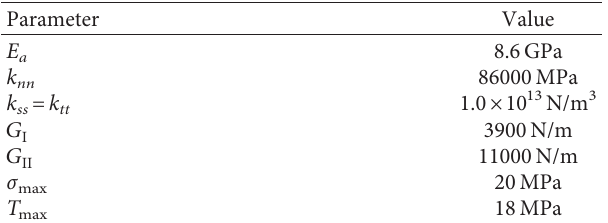
Table 1: Properties of adhesive.